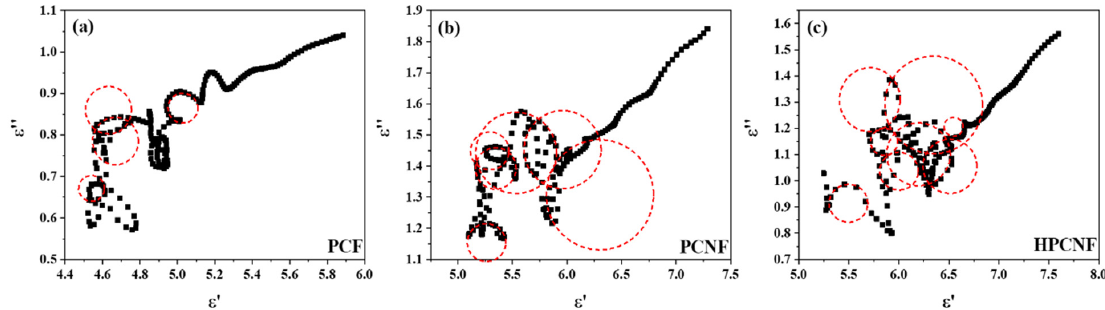
Figure 9. Cole − Cole plots of microwave absorbing composites with different absorbers: ( a ) PCF; ( b ) PCNF; ( c ) HPCNF.